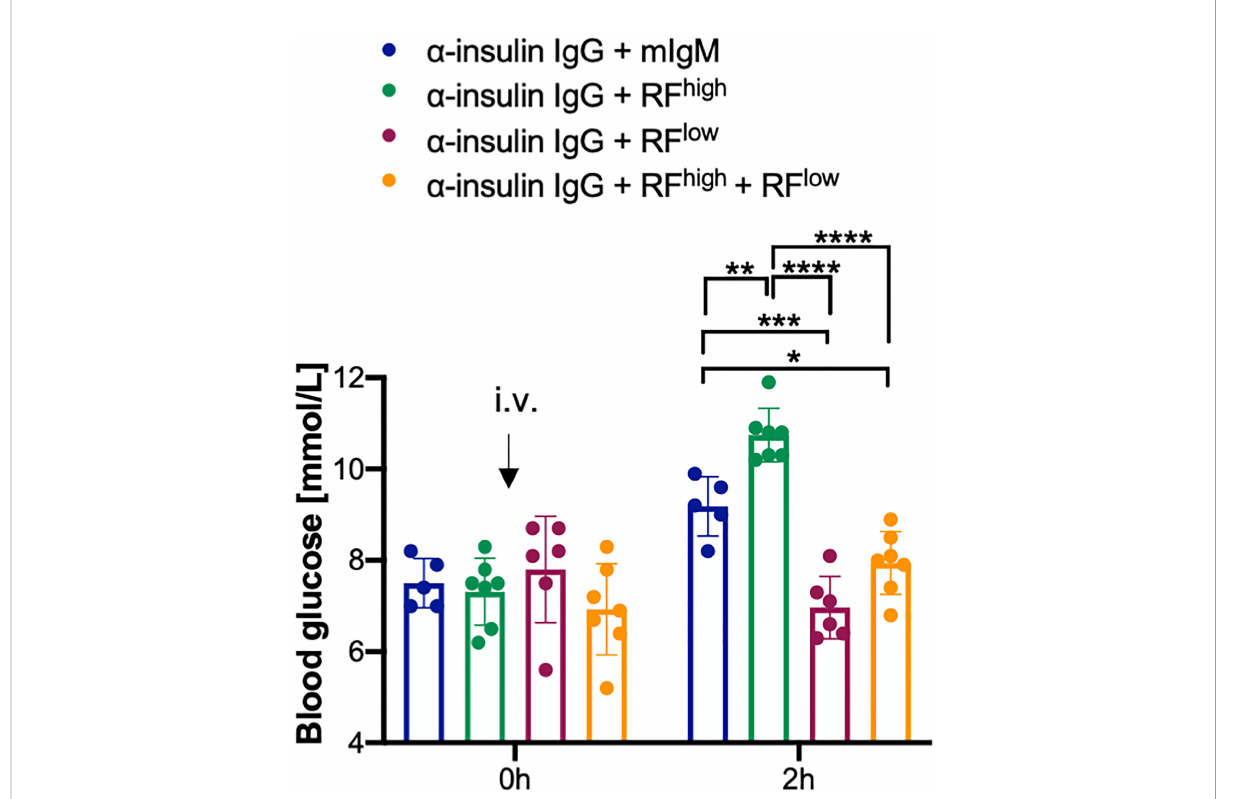
FIGURE 5 RF low prevails over RF high . Blood glucose concentrations of WT mice intravenously (i.v.) injected with 100 µg a -insulin IgG in combination with 20 µg RF high (green bar, n = 7), 20 µg RF low (purple bar, n = 6), 20 µg RF low + 20 µg RF high (orange bar, n = 7) or mIgM control (blue bar, n = 5) measured at indicated time points. Mean ± SD, statistical signi fi cance was calculated using two-way ANOVA with Tukey ’ s multiple comparisons test. *p < 0,05; **p < 0,01; ***p < 0,001; ****p <